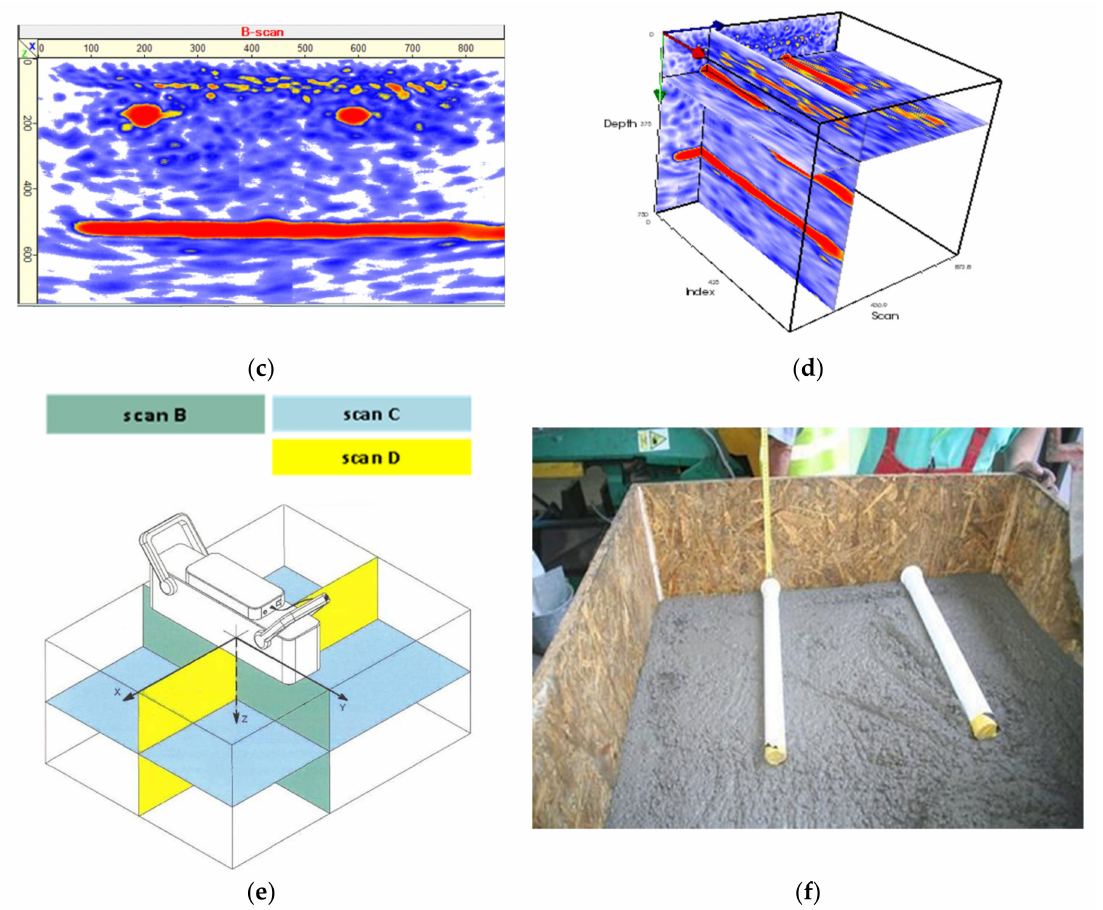
Figure 2. Example of ultrasonic tomography scans for a concrete member filled with air PVC pipes: ( a ) exemplary scan C, ( b ) exemplary scan D, ( c ) exemplary scan B, ( d ) 3D scan, ( e ) names of cross sections (scans) of tested object and coordinate system used with a tomograph antenna, and ( f ) the view of the embedded